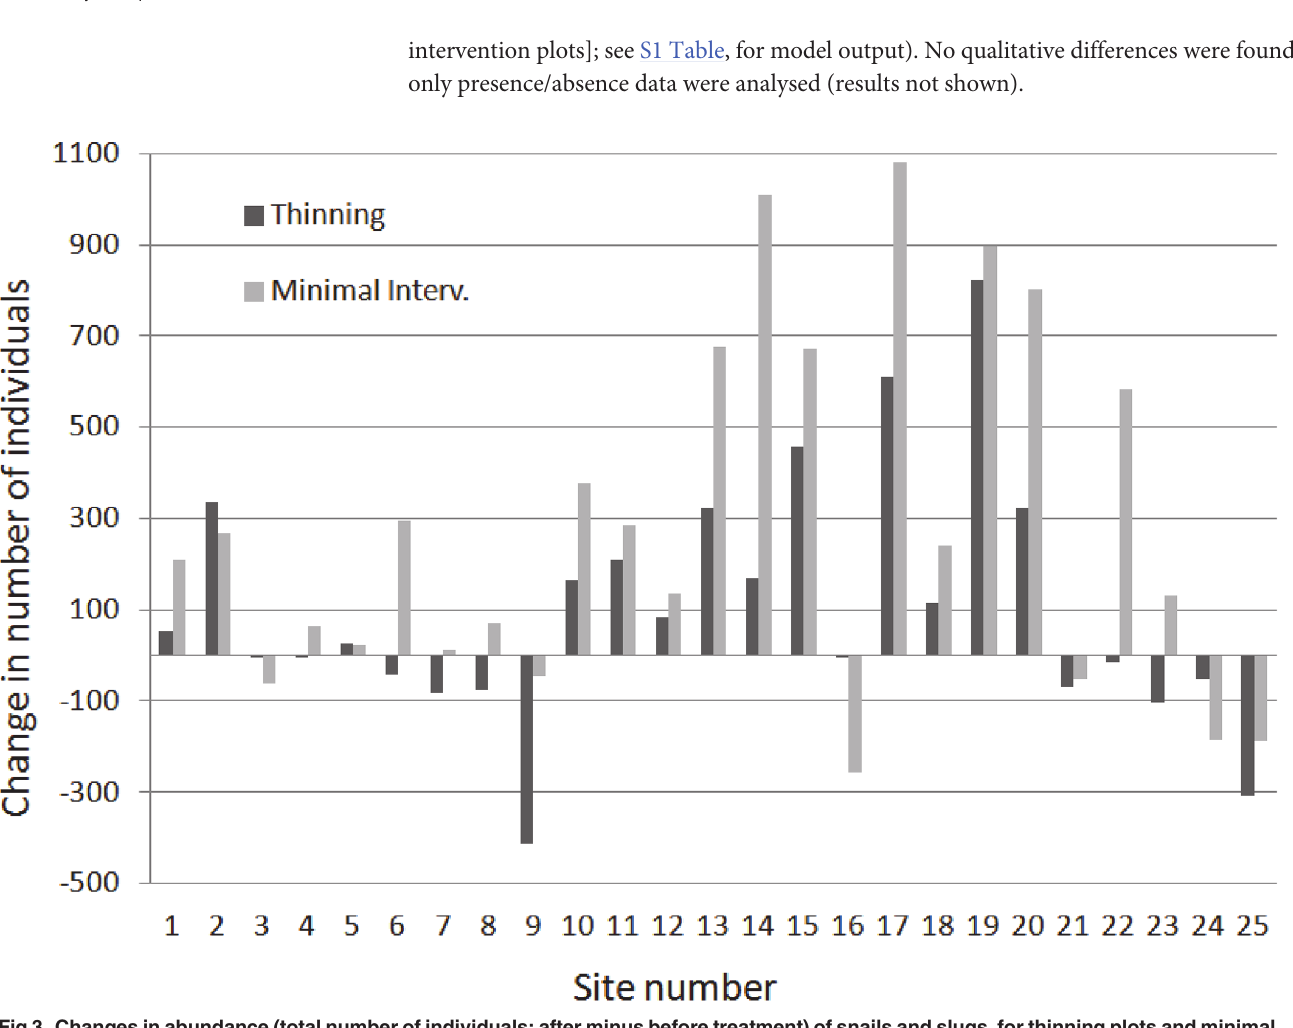
Fig 3. Changes in abundance (total number of individuals; after minus before treatment) of snails and slugs, for thinning plots and minimal intervention plots. For site number and location, see Fig.